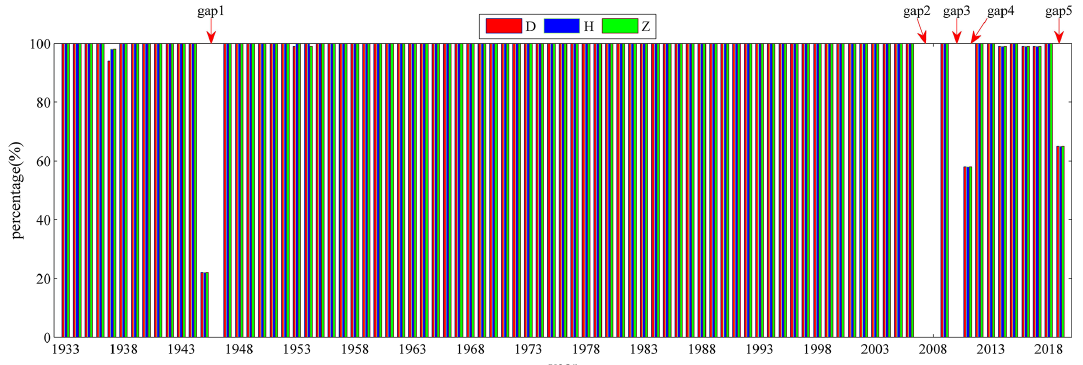
Figure 4. The completeness of the AHMVs from 1933 to